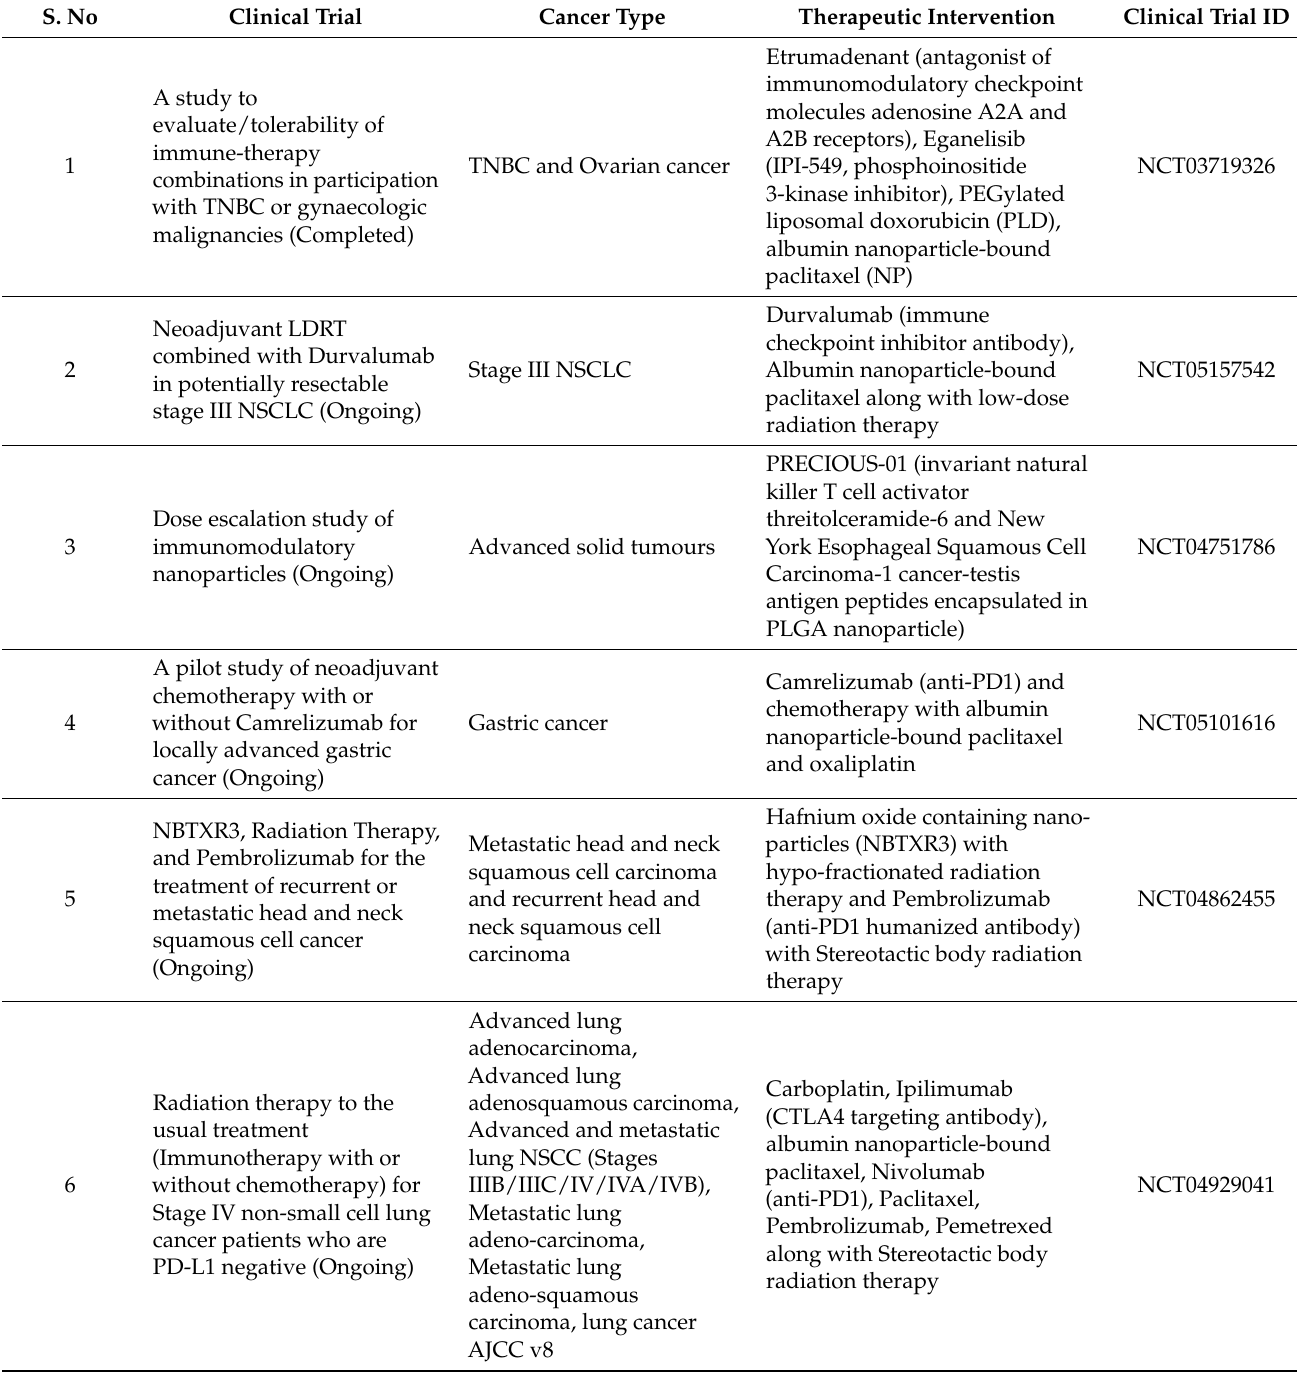
Table 3. Clinical trials (completed and ongoing) involving nanoparticles for cancer immunotherapy. S.